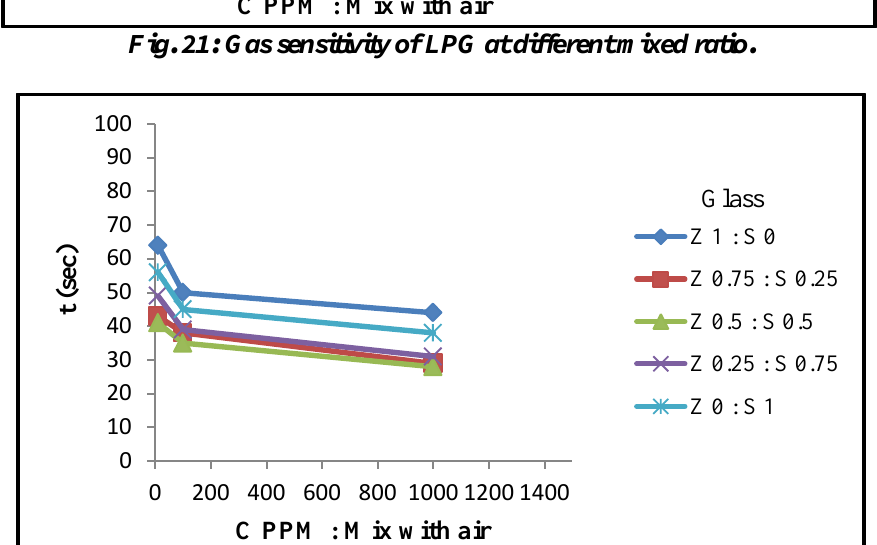
Fig. 21: Gas sensitivity of LPG at different mixed ratio.